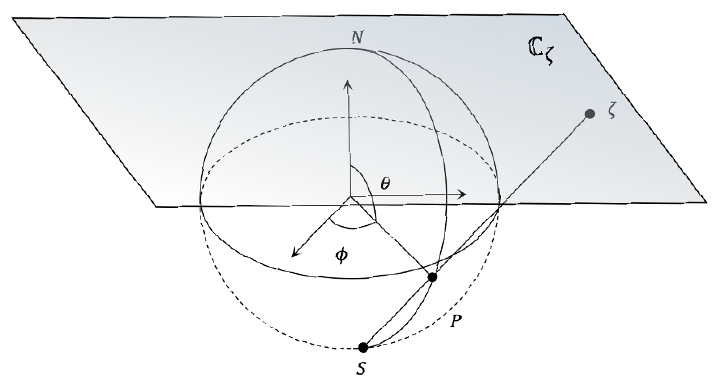
Figure 2 . The representation of a direction ( (cid:18); (cid:30) ) in the sky S + as a stereographic coordinate (cid:16) on the complex plane C (cid:16)